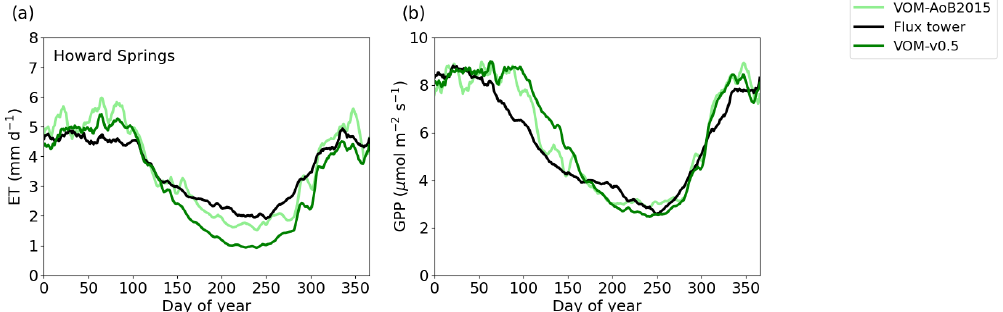
Figure 6. Ensemble years of evapotranspiration (ET) and gross primary productivity (GPP) for the VOM-v0.5 (dark green), flux tower observations (black) and VOM-AoB2015 (light green), all smoothed by a 7d moving average. The ensemble years are calculated for the overlapping time periods with the flux tower observations (7 August 2001 until 21 December